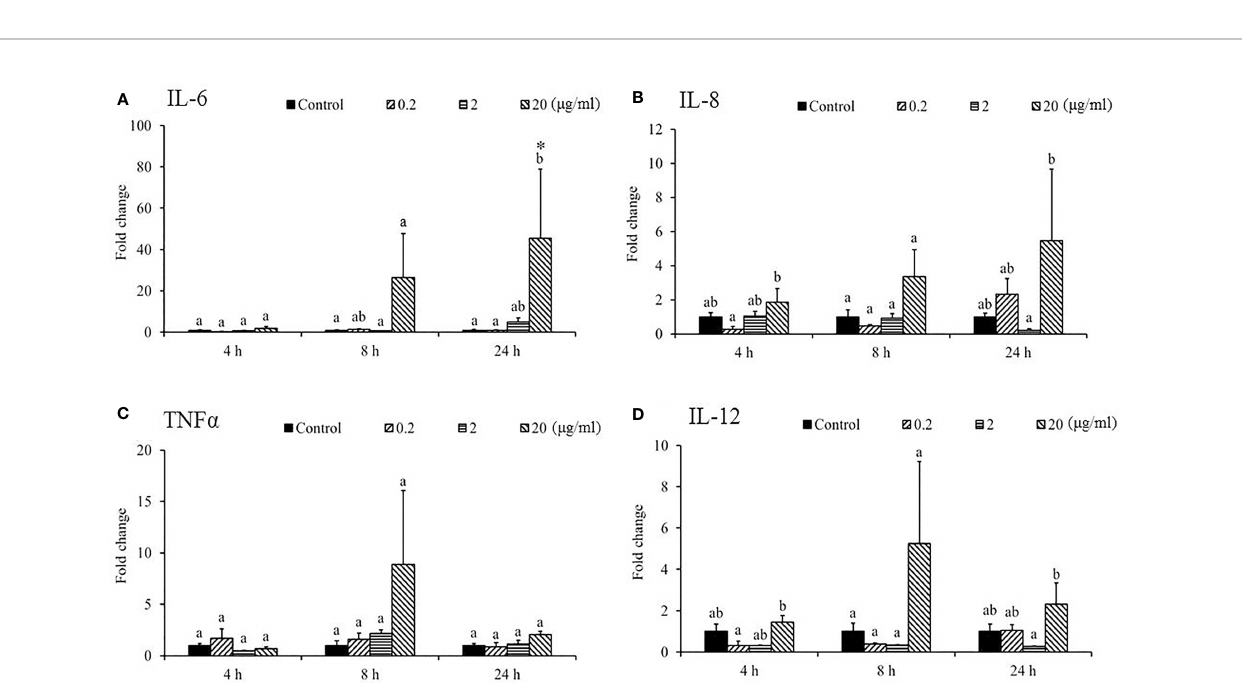
was sharply induced at 4 h in the group given the highest amount of SSWE. Noticeably, an upregulation of IgT was recorded in the groups that received 2 and 20 m g of SSWE per gram fi sh BW at 8 and 24 h, respectively ( Figure 5E ).